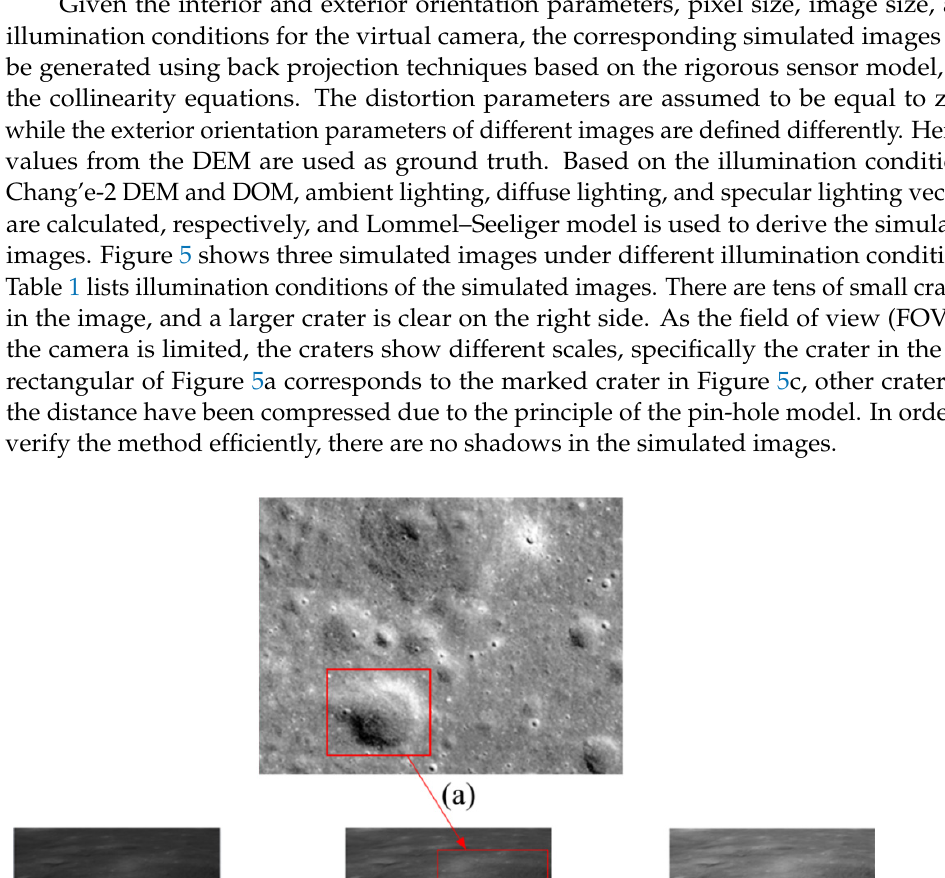
Figure 4. ( a ) DEM and ( b ) DOM for rover image simulation.